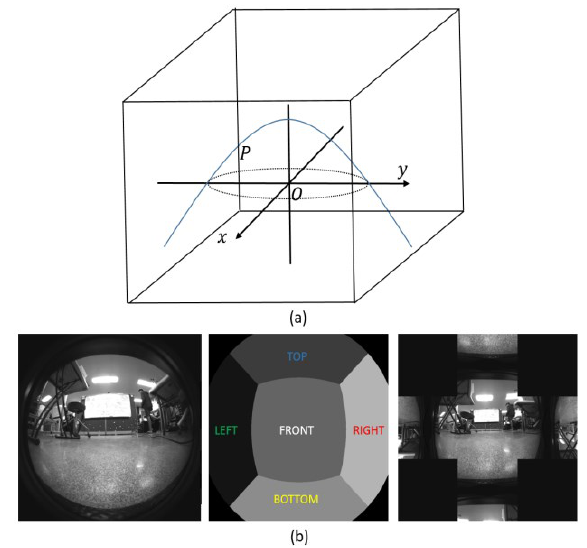
Figure 5 . (a) Illustration of EUCM-Cubemap projection model. (b) Convert fisheye image to the cubemap Image.